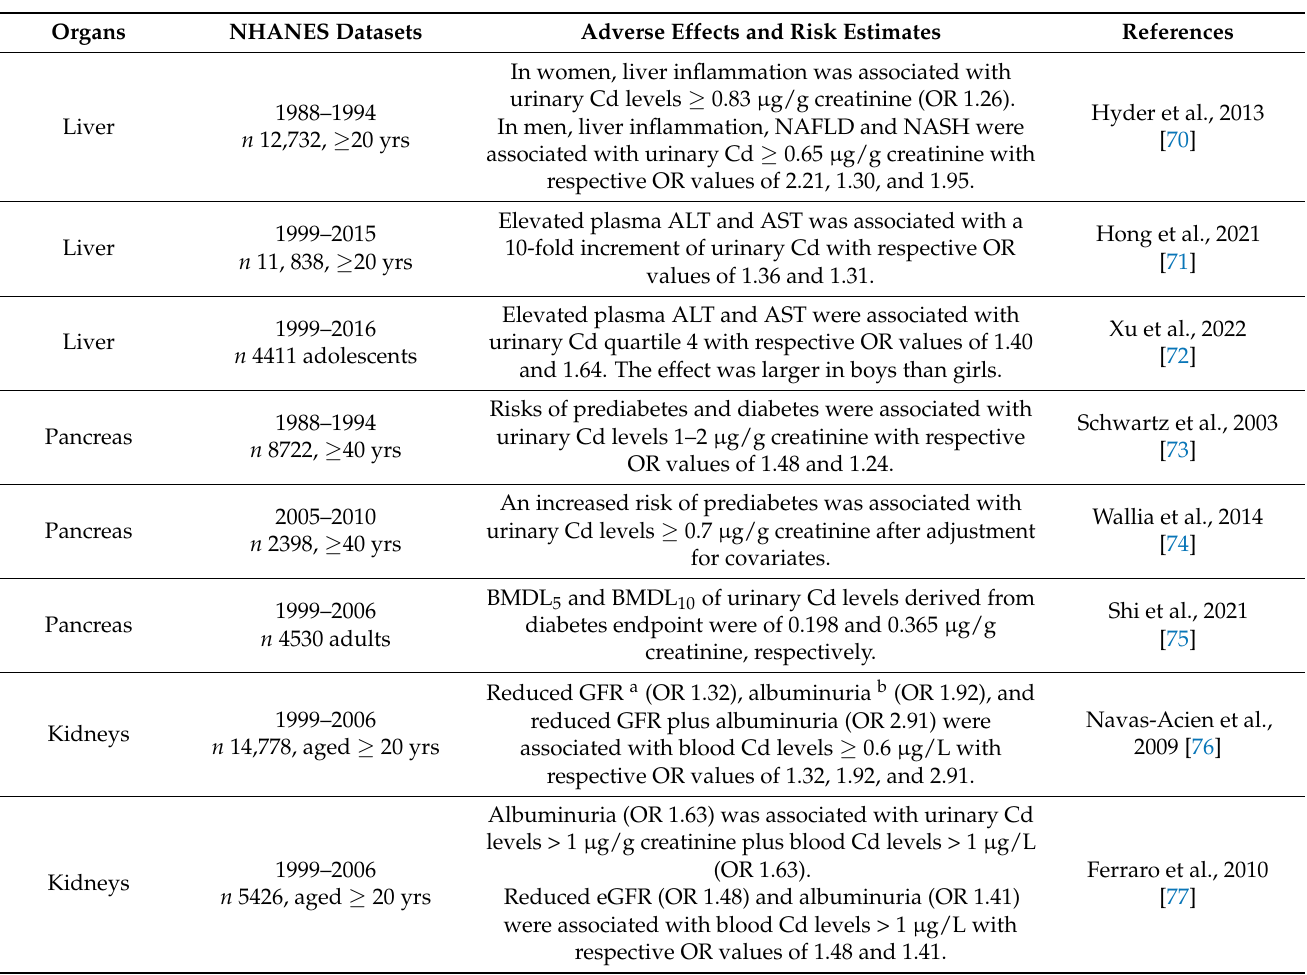
Table 1. Adverse health effects of cadmium exposure in multiple organs evident from the U.S. NHANES